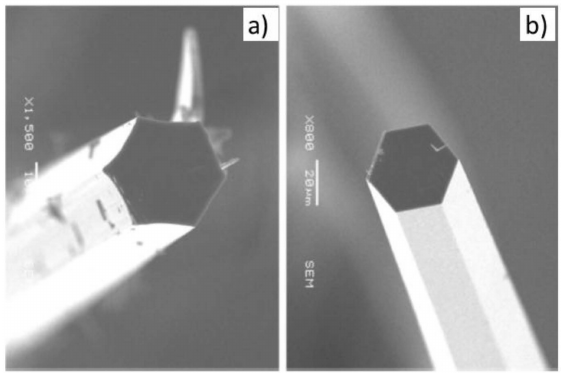
Figure 5. SEM images of a ZnO wire with curved ( a ) and straight ( b ) sides. Reprinted from [36] with permission from